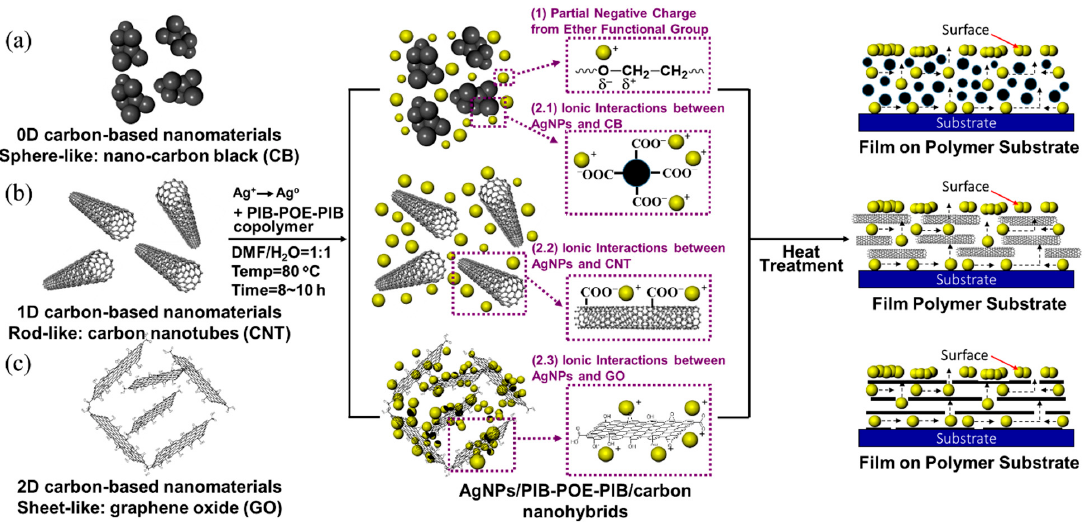
Figure 2. Adsorption mechanisms for dispersion and stabilization of the three silver nanoparticles (AgNPs)/PIB-POE-PIB/carbon-based nanomaterial hybrids according to various types of intermolecular forces. ( a ) AgNPs/PIB-POE-PIB/nano-carbon black (CB), ( b ) AgNPs/PIB-POE-PIB/carbon nanotubes (CNT), and ( c ) AgNPs/PIB-POE-PIB/graphene oxide GO.